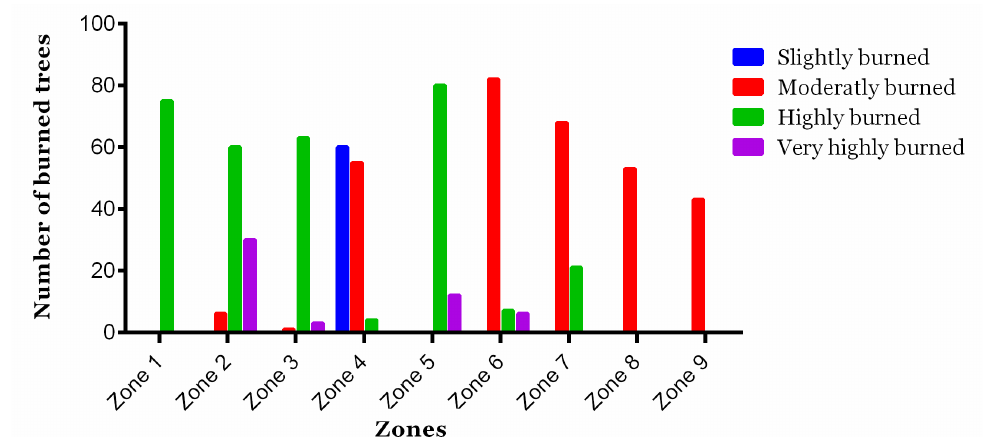
Figure 2. Number of burned trees in each zone as per fire severity class.